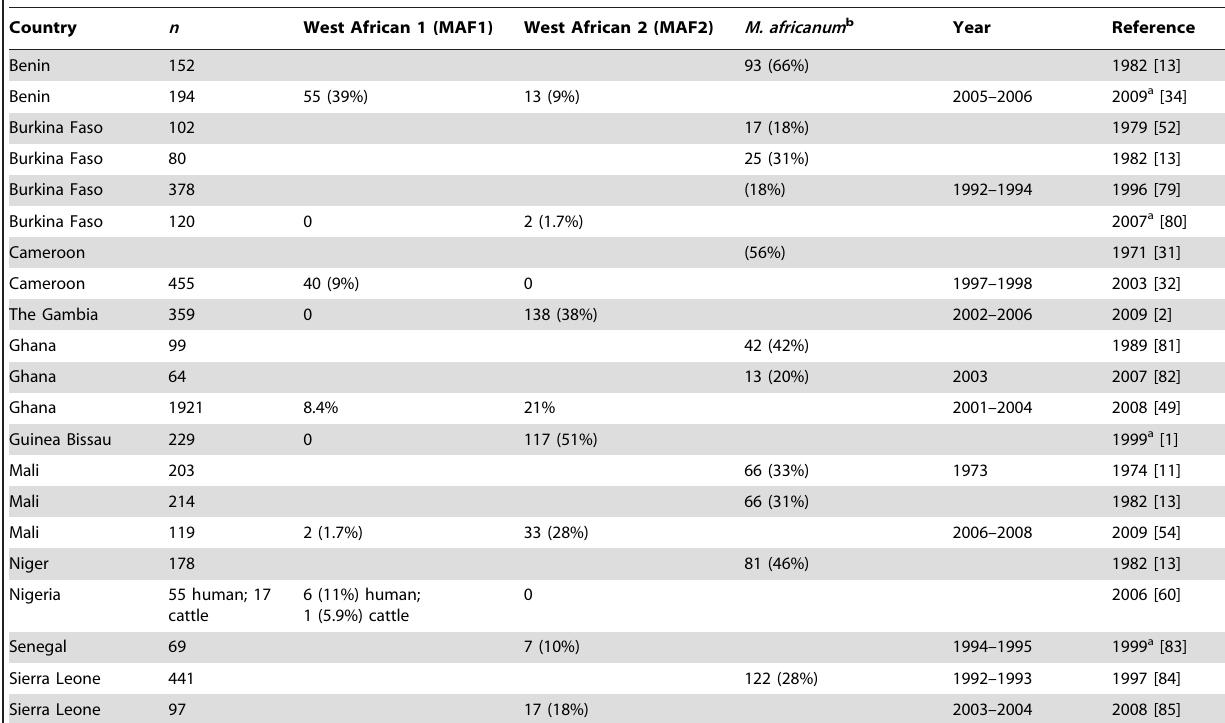
Table 2. Prevalence of M. africanum in Different West African Countries.